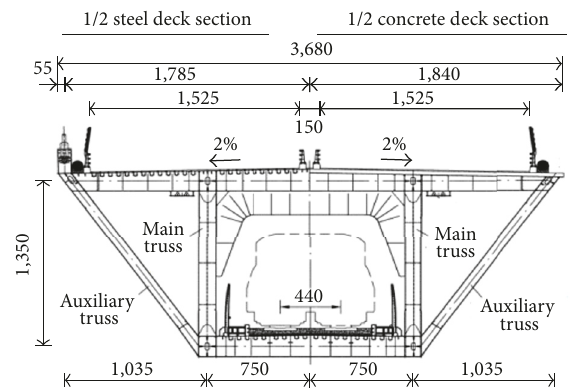
Figure 4: The girder cross section of Daxiao Liandao waterway bridge (unit: